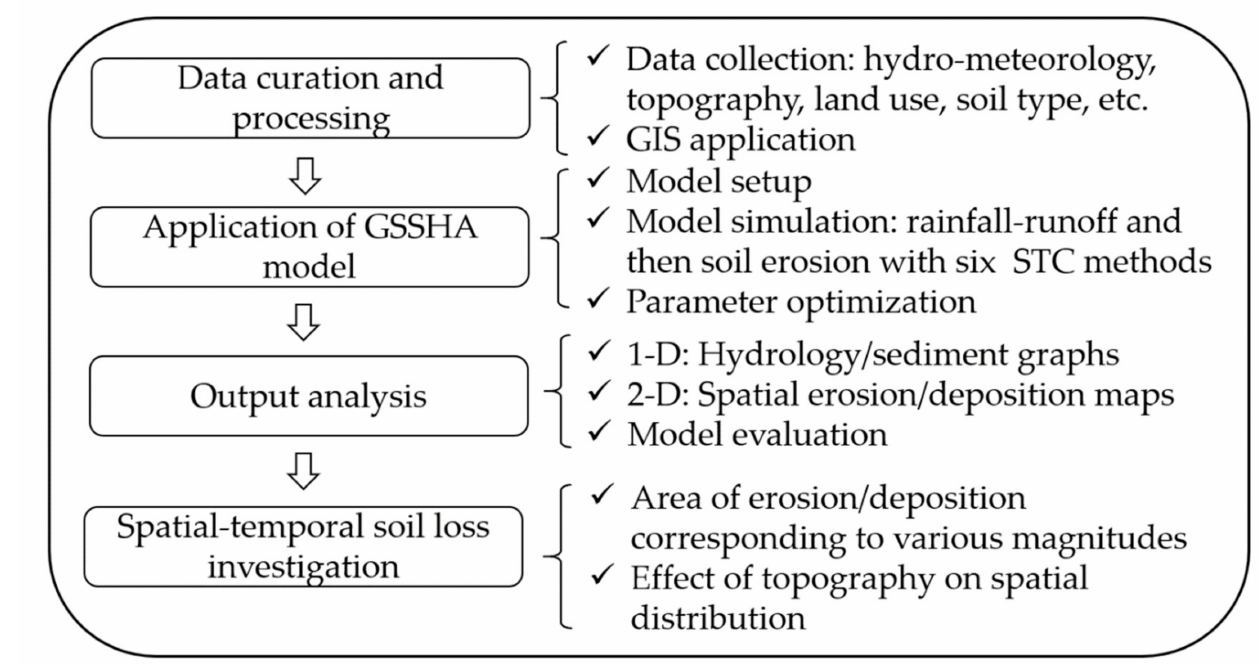
Figure 1. The schematic diagram of the